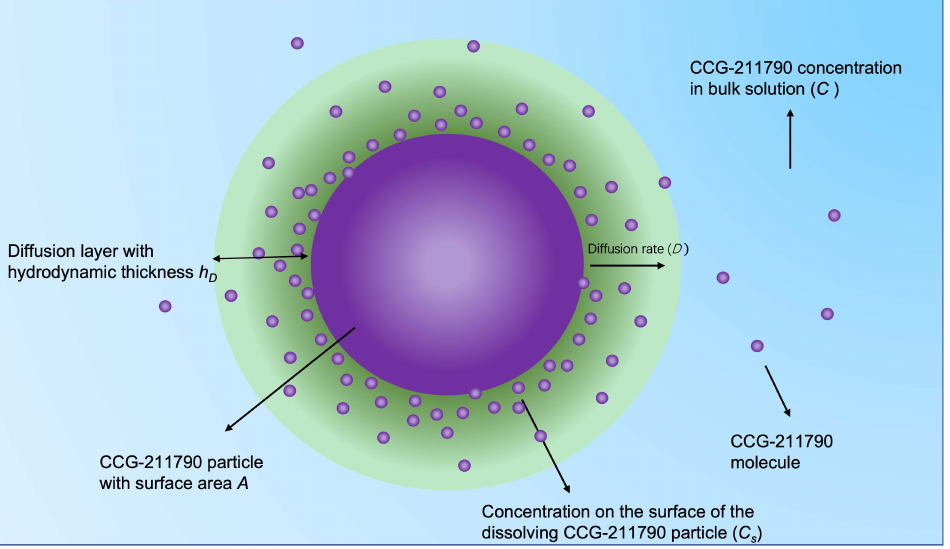
Figure 7. Schematic of the diffusion layer proposed by Noyes and Whitney and further modified by Nernst and Brunner. Particle size reduction leads to increased surface area A and decreased hydrodynamic layer thickness h D , therefore increasing dissolution rate